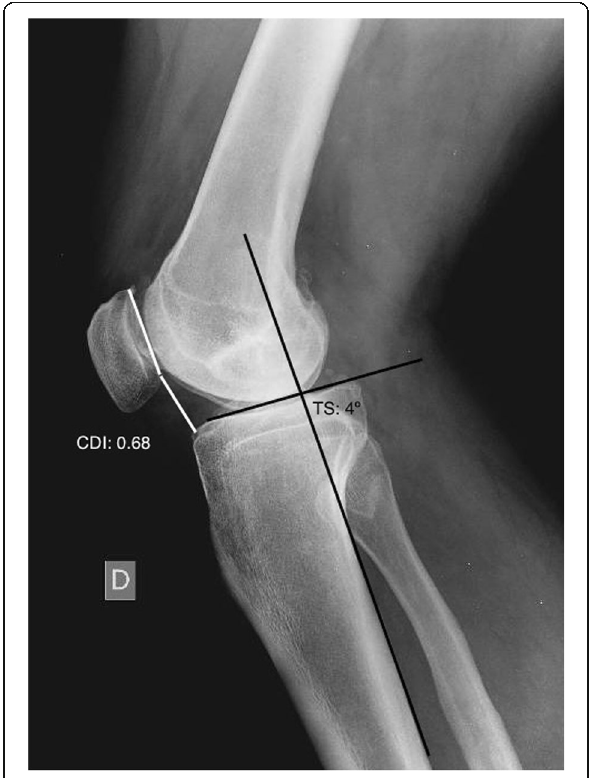
Fig. 1 Measurement of the Caton-Deschamps index and the posterior tibial slope. CDI: Caton- Deschamps index, TS: tibial